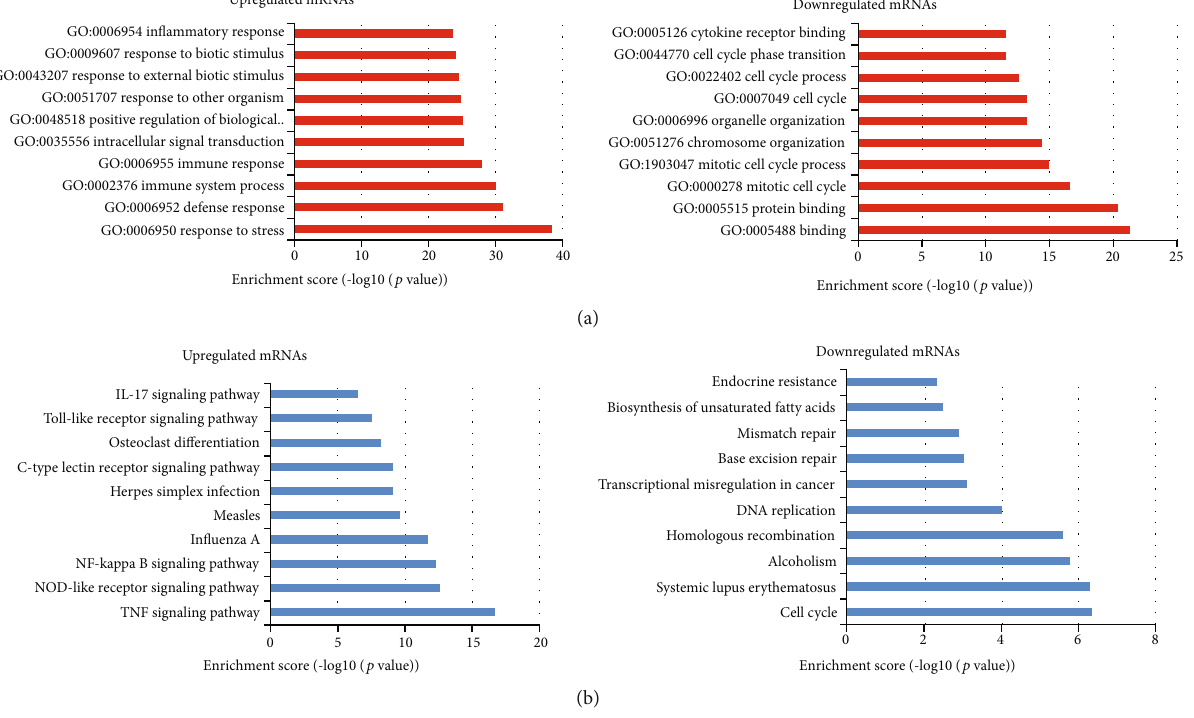
Figure 4: Gene Ontology (GO) and KEGG pathway analyses. (a) GO MF terms for upregulated and downregulated mRNAs were analyzed. Top 10 upregulated and 10 downregulated GO terms ranked by fold enrichment and enrichment score were shown. (b) KEGG pathway enrichment analysis of up- and downregulated mRNAs was performed. Top 10 pathways ranked by the enrichment score were